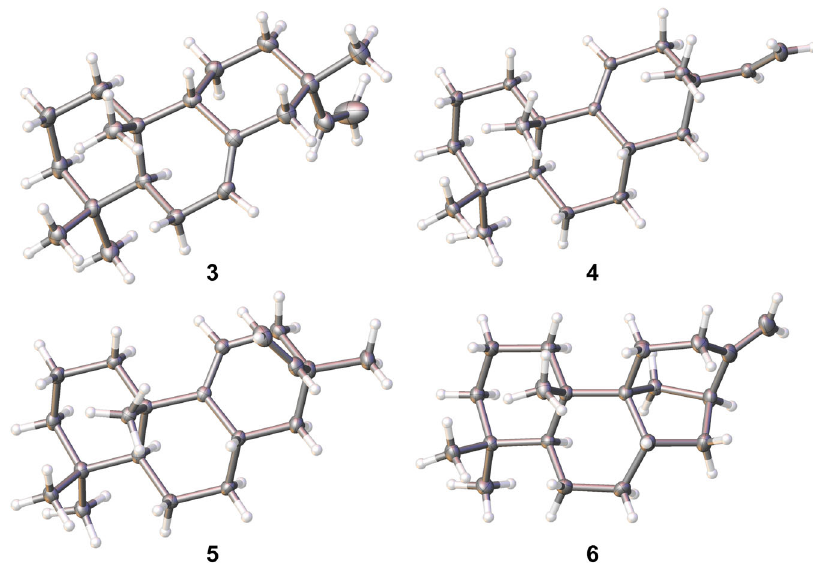
Fig. 2 The crystal structures of compounds 3 – 6. The CIF fi les of these structures have been submitted as Supplementary Data 4 –